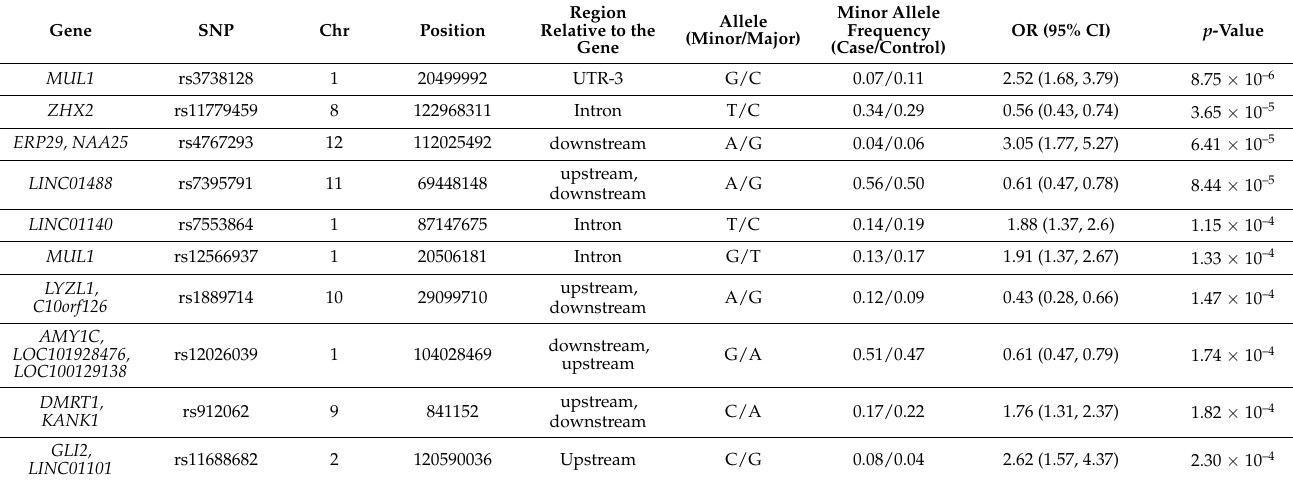
Figure 2. Manhattan plots for dementia in Parkinson’s disease (PD). The genes nearest to the top 10 significant variants are labeled. The x -axis represents the base pair position of the variants from chromosome 1 to chromosome 22. The MUL1 loci was most significantly associated with dementia in PD. MUL1 SNP rs3738128 (OR = 2.52, 95% CI = 1.68–3.79, p = 8.75 × 10 –6 ) was most significantly associated with dementia in PD. The ZHX2 and ERP29 loci were also associated with dementia in PD. Table 3. Top 10 genetic variants associated with dementia in Parkinson’s disease in the order of statistical